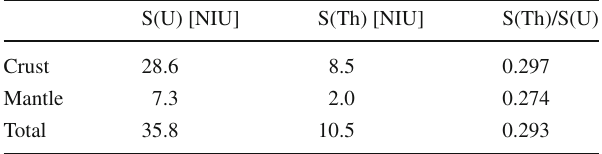
Fig. 2 The expected rate of antineutrino interactions at SURF, as the function of antineutrino energies. 1 NIU (Neutrino Interaction Unit) = 1 IBD interaction/10 32 targets/year. Source: geoneutrinos.org [52] Table 4 The inputs for the geoneutrino signal simulation. 1 NIU (Neu- trino Interaction Unit) = 1 IBD interaction/10 32 targets/year